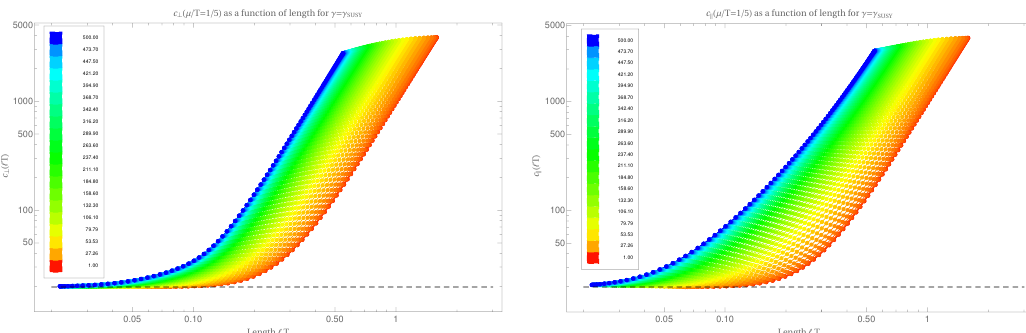
Figure 16 . We display the c-functions at γ = γ SUSY computed in two ways, firstly via direct numerical calculation utilizing eq. (4.18) and eq. (4.19) (lines), and secondly via the conserved charge as given in eq. (4.37) and eq. (4.38) (dots). Left: ∆ c ⊥ . Right: ∆ c are displayed as a function of dimensionless length ‘T at fixed µ/T = 1 / 5 for B/T 2 varying from B/T 2 = 1 . 00 to B/T 2 = 500 . 00 .